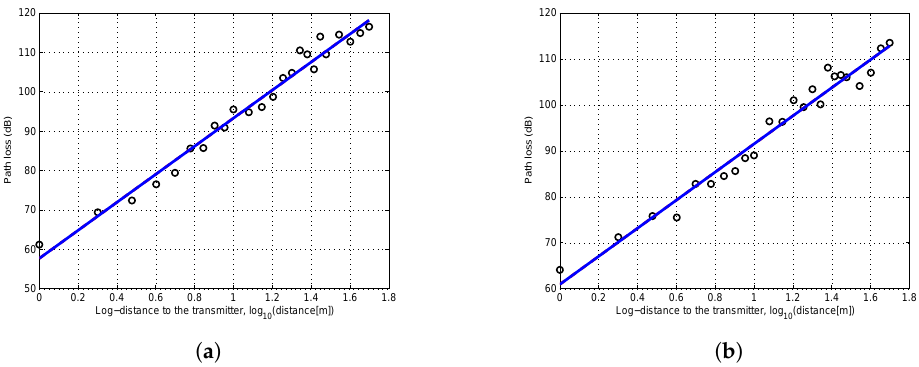
Figure 7. Least squares fitting of measurement results in two derived scenarios: ( a ) undulating grass, H t = H r = 5 cm; and ( b ) flat grass with obstacles, H t = H r = 5 cm.